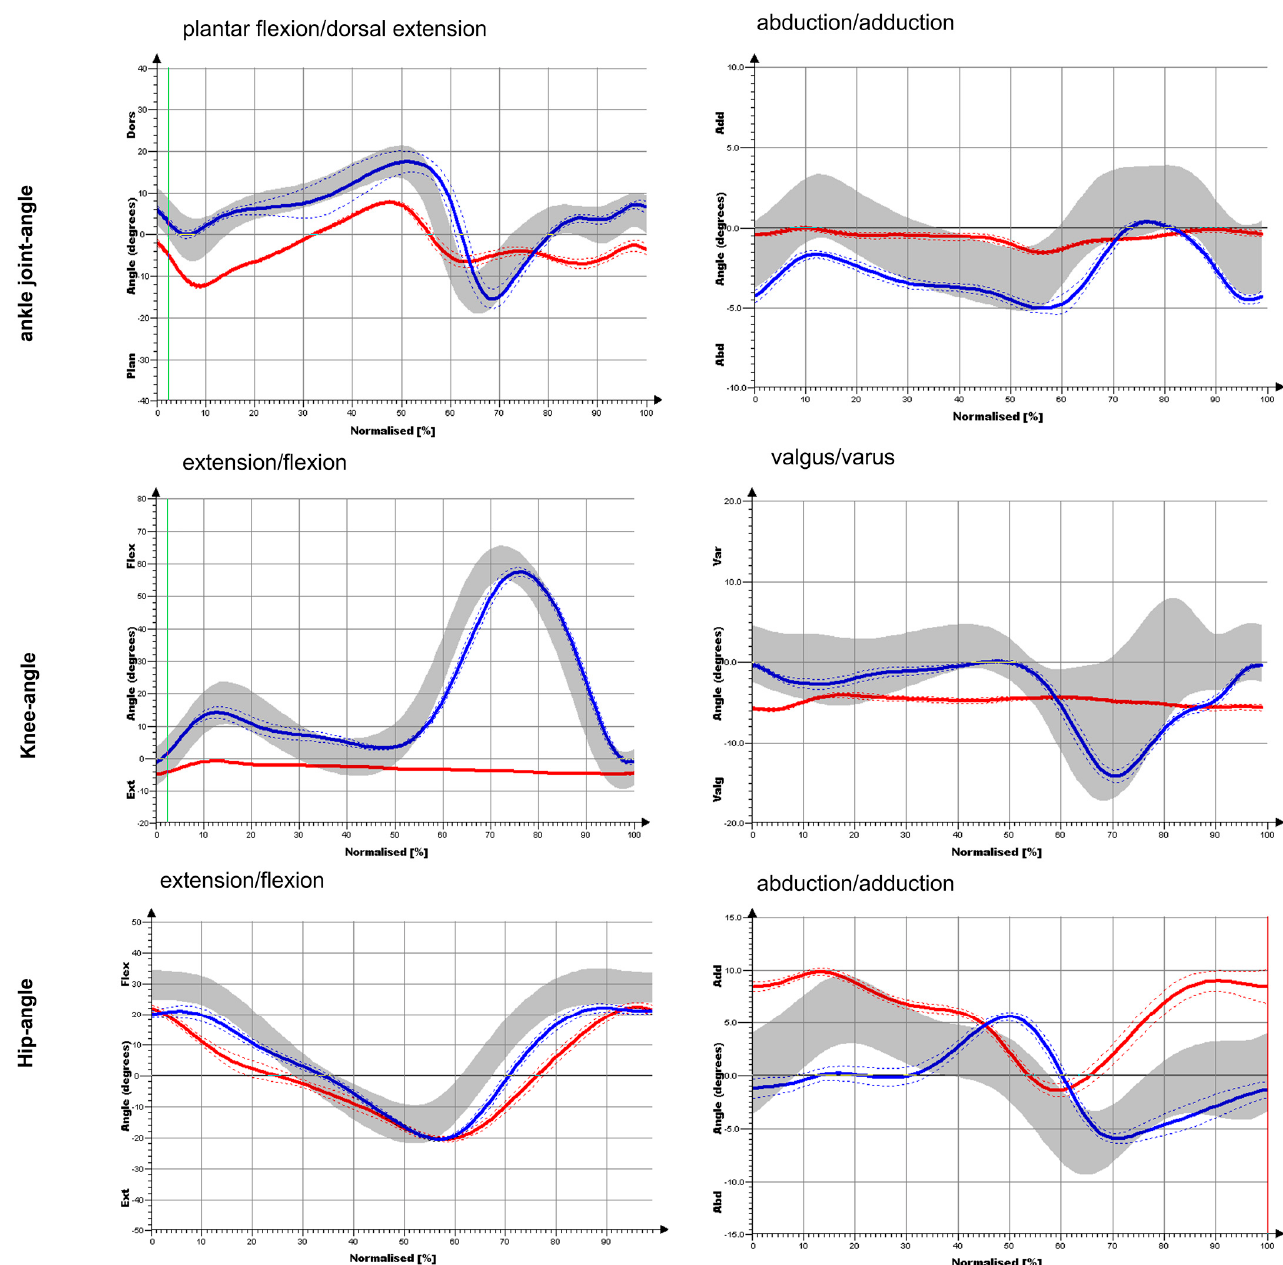
Figure 4. Joint angle progression of the ankle joint, knee and hip during a complete gait cycle in the sagittal plane (flexion/extension) and frontal plane